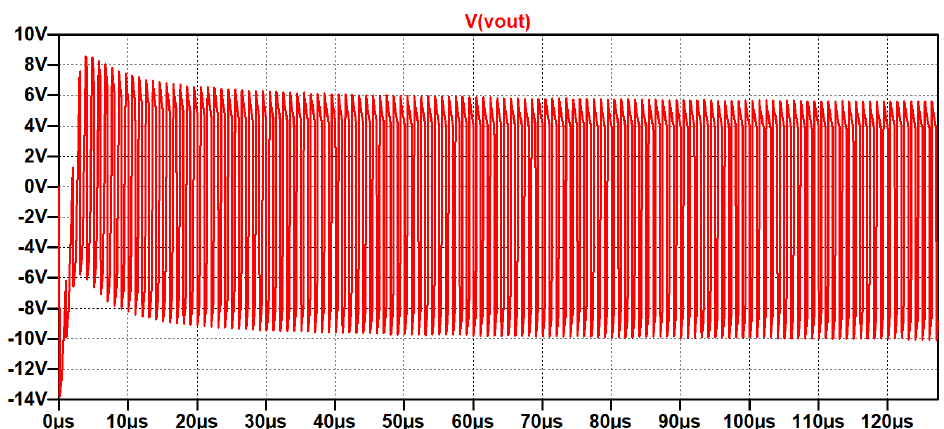
Figure 8. The output voltage response of circuit with GaN switch and resistive load configuration.